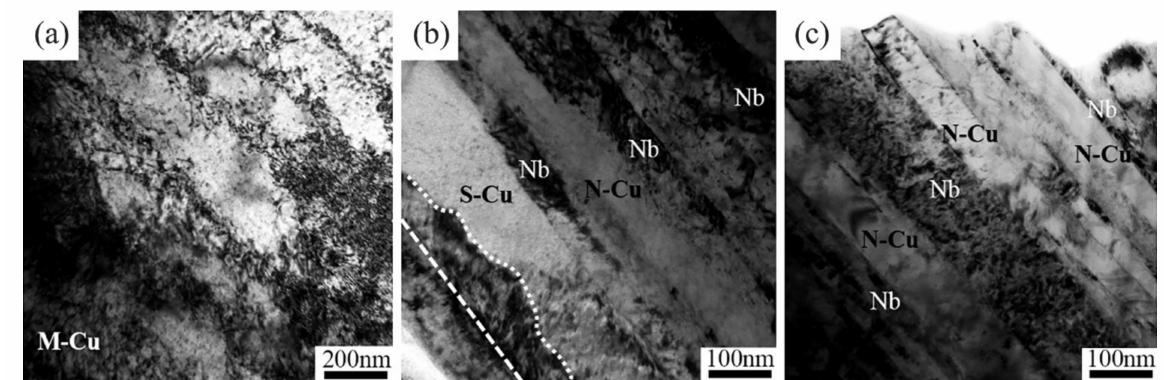
Figure 4. Bright field TEM images of 85 4 sample ( a ) dislocation cells in M-Cu, ( b ) longitudinal sections showing Nb fibers surrounded by S-Cu and N-Cu, and ( c ) longitudinal sections showing clean N-Cu and Nb